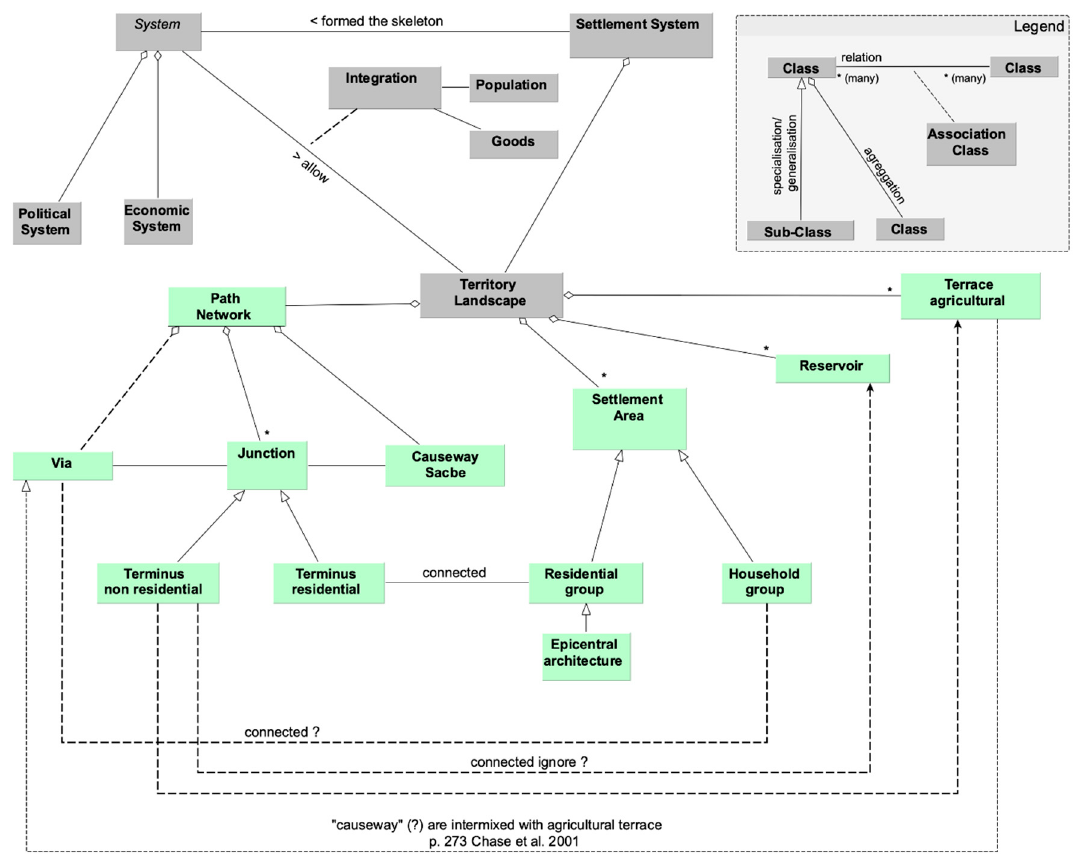
Figure 5. Unified Modeling Language (UML) schema of a circulation system at Caracol, Belize.